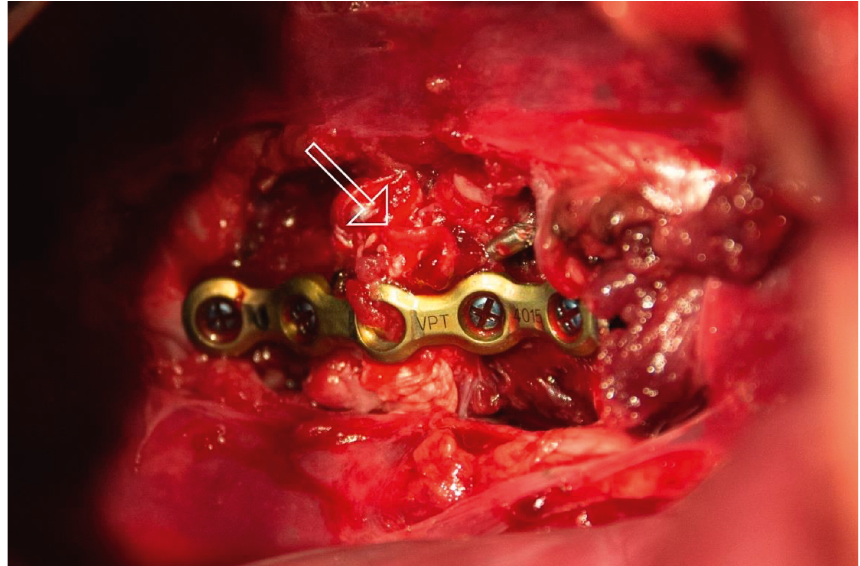
Figure 3: Surgical view after stabilization of Th11-Th12 IVD space of one dog with 2-0 UniLock osteosynthesis plate secured with four monocortical titanium locking screws and one pin via a thoracic approach. White arrow: complete loss of discal structure of Th11-Th12.